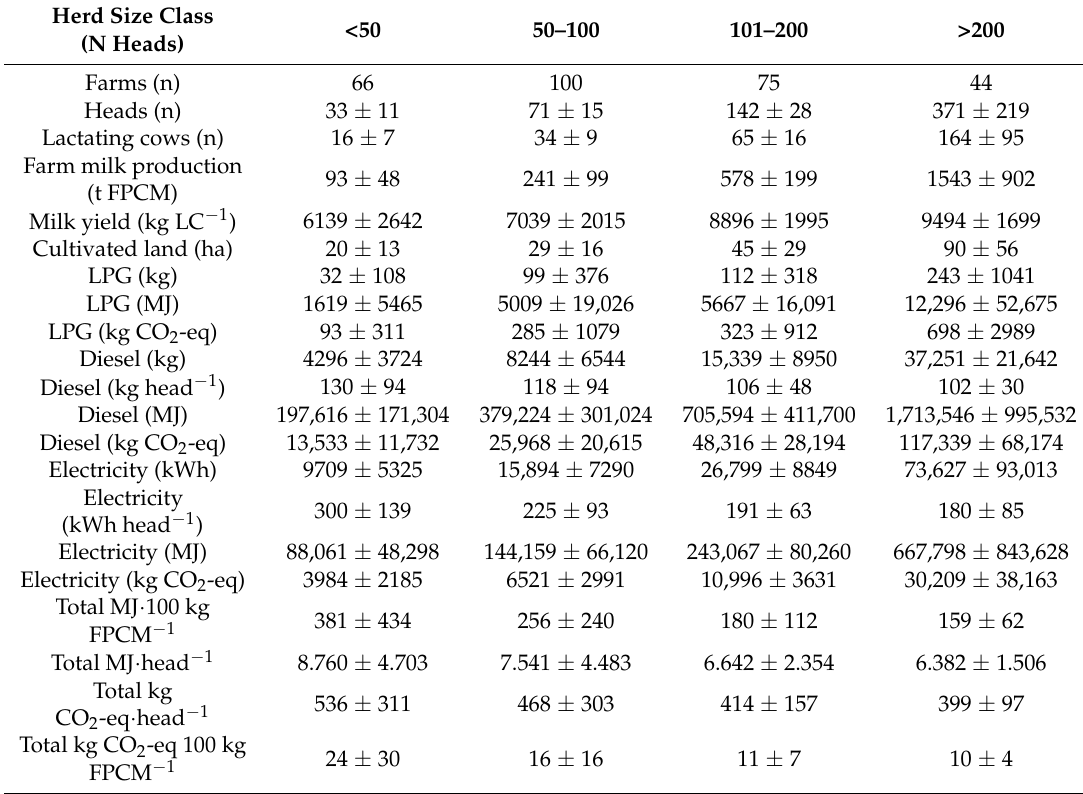
Table 3. Primary energy consumption and carbon dioxide emissions on a yearly basis, averages and standard deviation for herd size classes (N = 285).